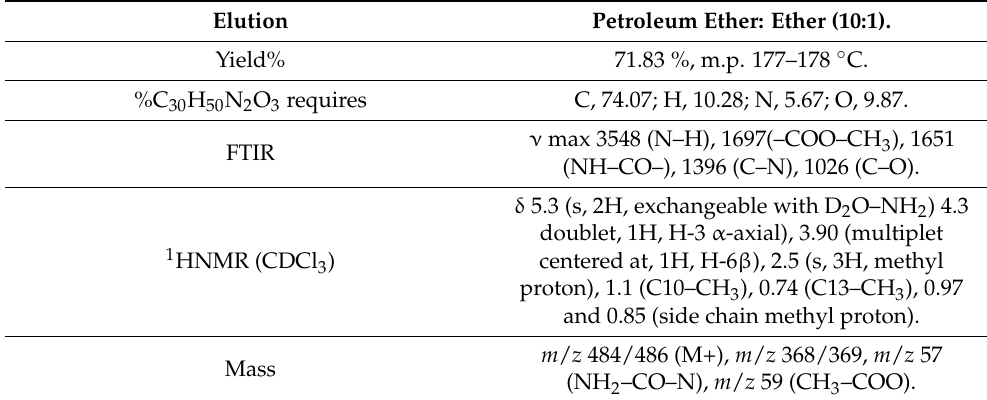
Table 4. FTIR, 1HNMR and mass analyses of 3 β -acetoxy-N-amido-5 α -cholestano aziridine ( VIII